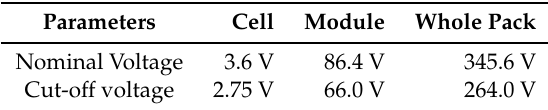
Table 1. Electrical parameters of the battery pack.